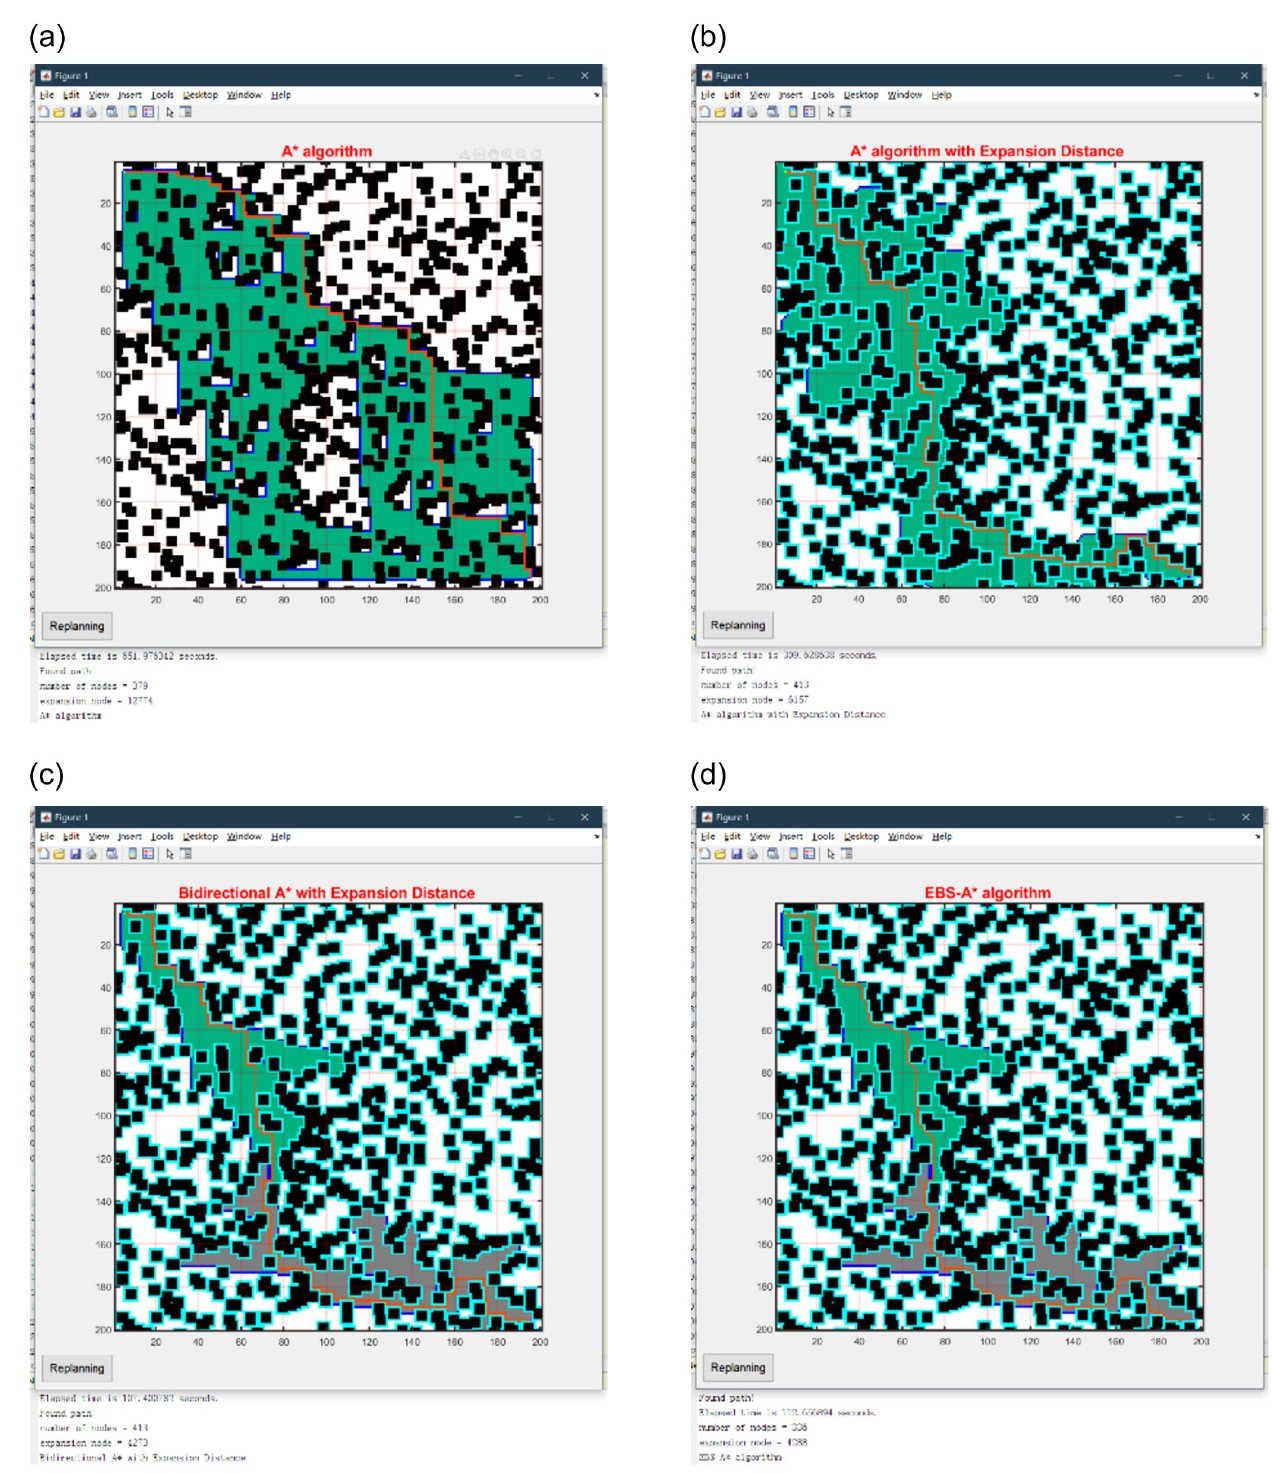
Fig 10. Simulation results of four algorithms on a 200 × 200 map. (a) A � algorithm. (b) A � with expansion distance. (c) Bidirectional A � with expansion distance. (d) EBS-A � algorithm.